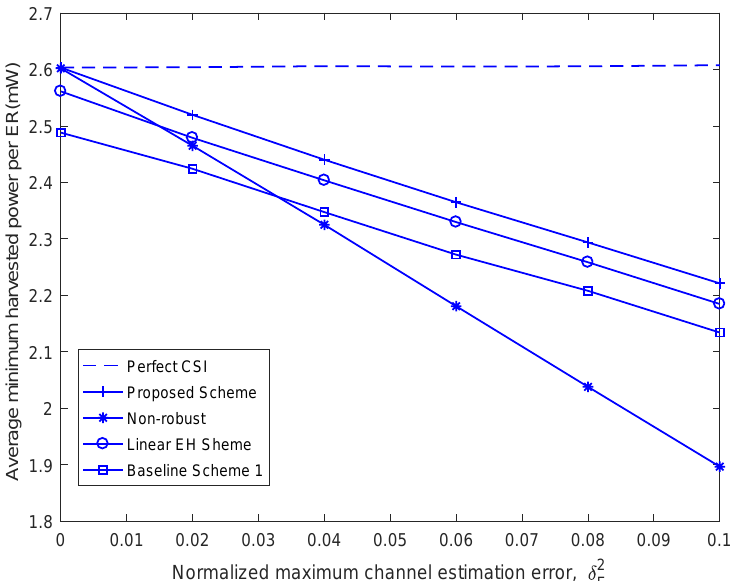
Figure 6. Average minimum harvested power per energy vehicular receiver versus channel estimation error, δ 2